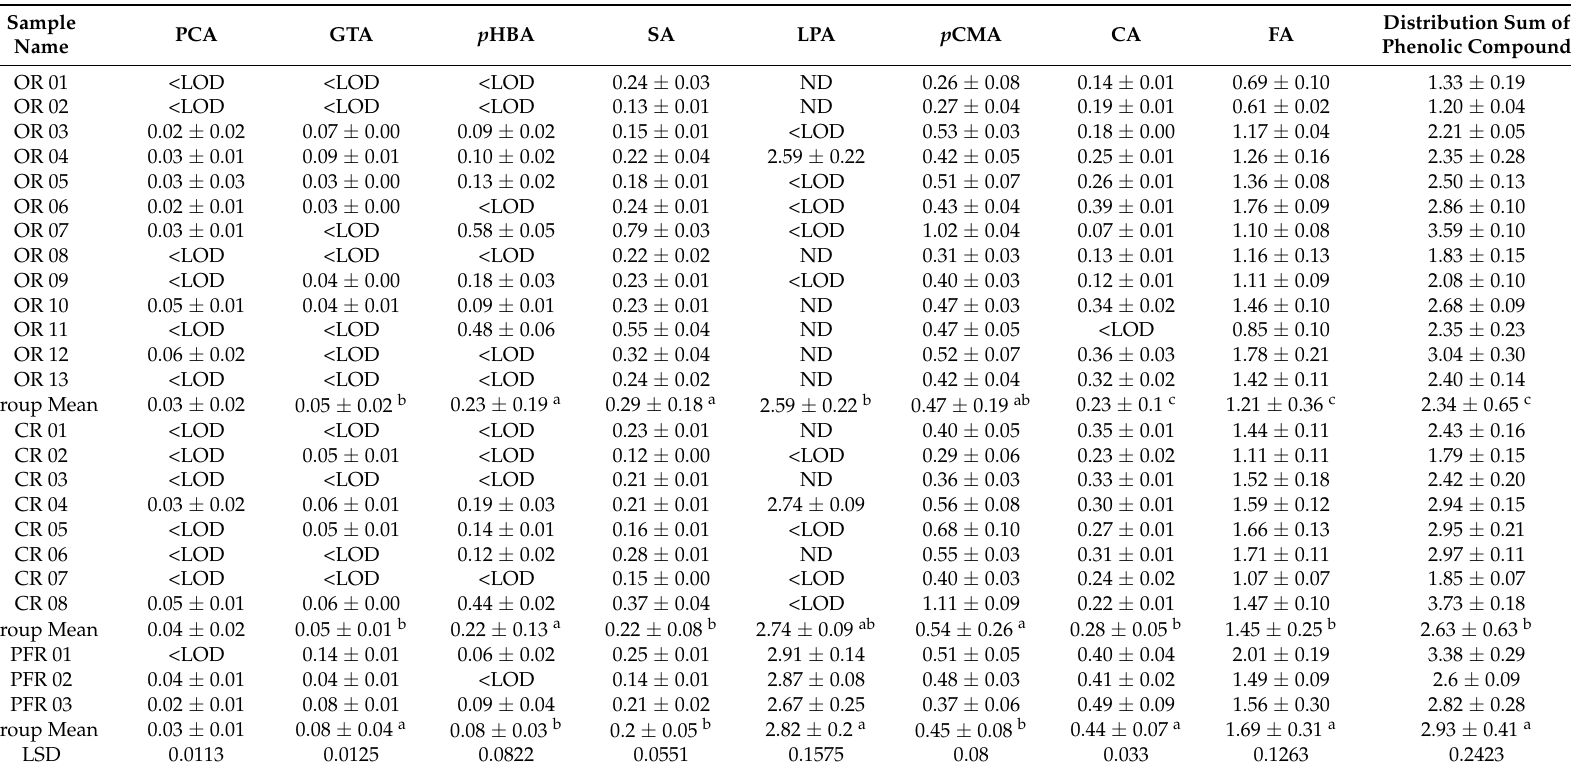
Table 1. Phenolic components present in the rice samples obtained using different farming systems ( µ g/g on a dry weight basis, injection and extraction n =